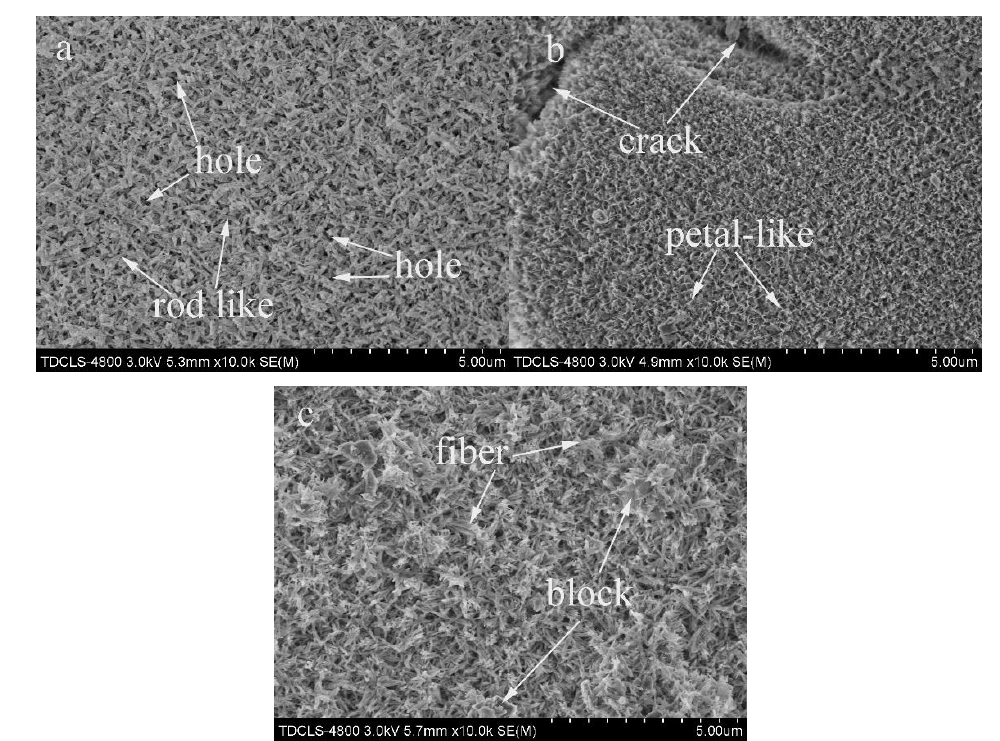
Figure 7. Surface morphology and EDS of SiC-hydroxyapatite coatings at different concentrations of SiC particles: ( a ) 0.01 g/L; ( b ) 0.1 g/L; ( c ) 1